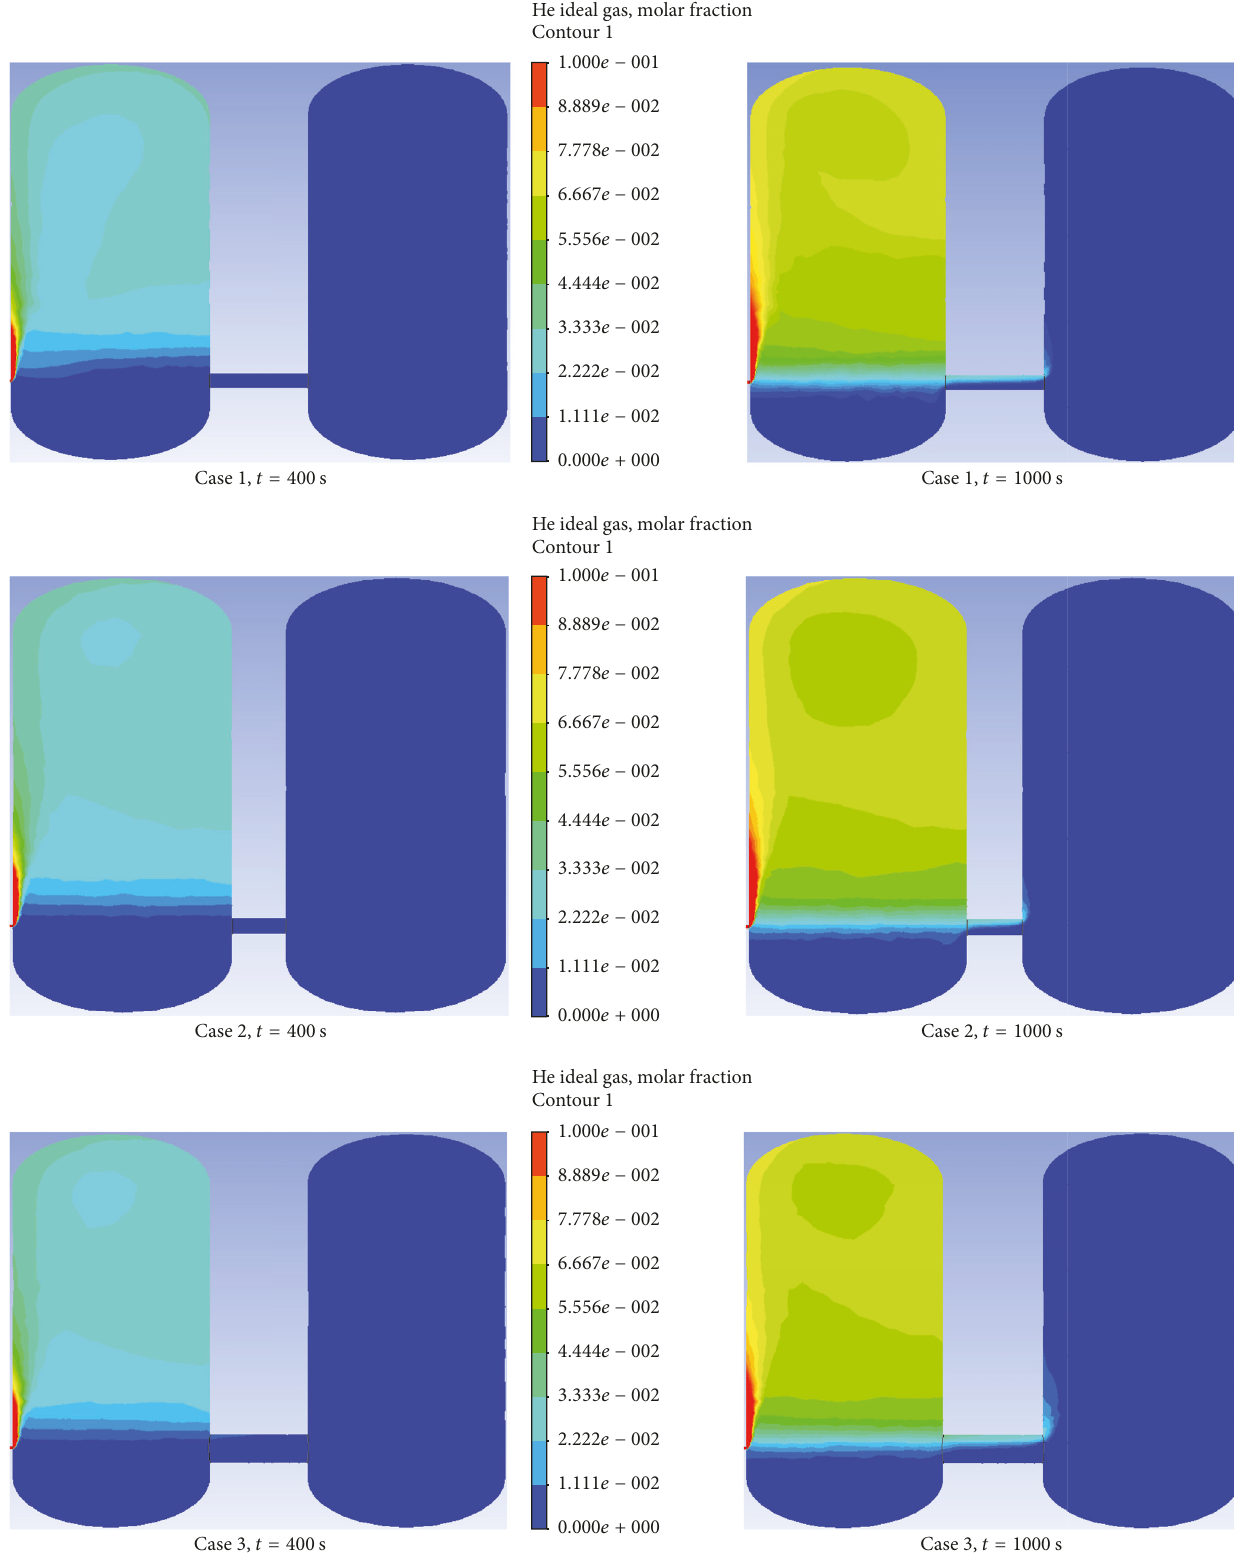
Figure 7: Hydrogen concentration at times 400 s and 1000 s in different